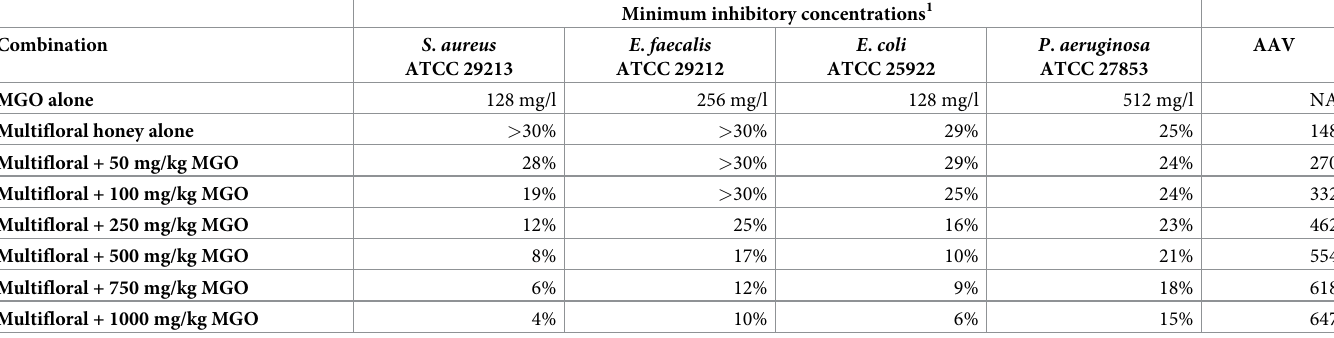
Table 5. Antibacterial activity of multifloral honey amended with concentrations of MGO ranging from 50 to 1000 mg/kg.